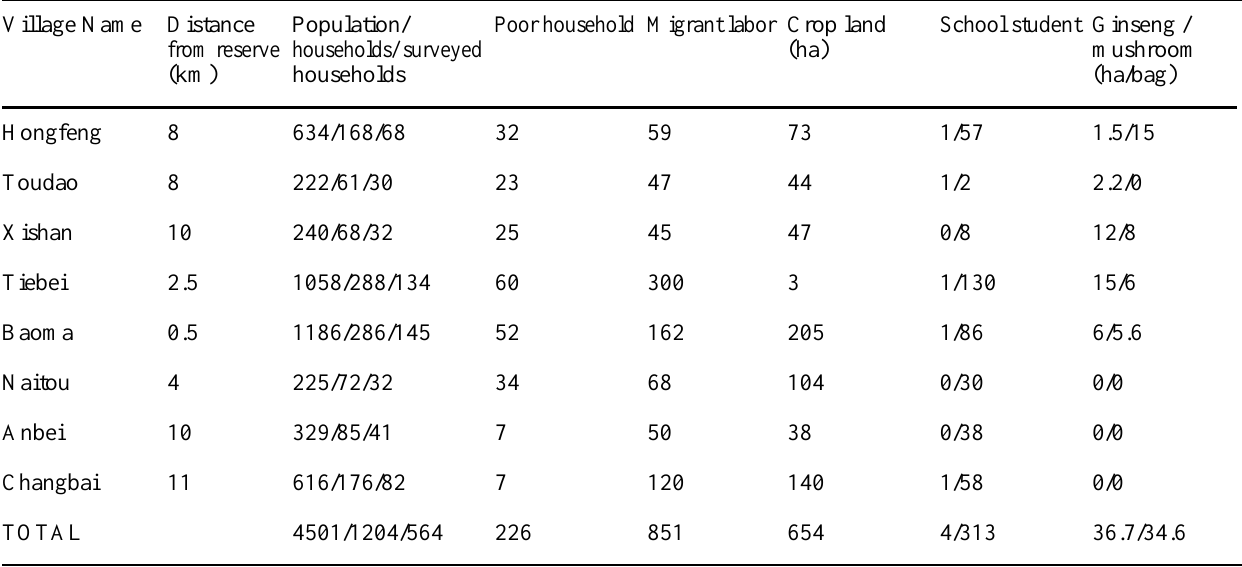
Table 1. Description of the eight study villages located along the boundary of the Changbai Mountain Biosphere Reserve